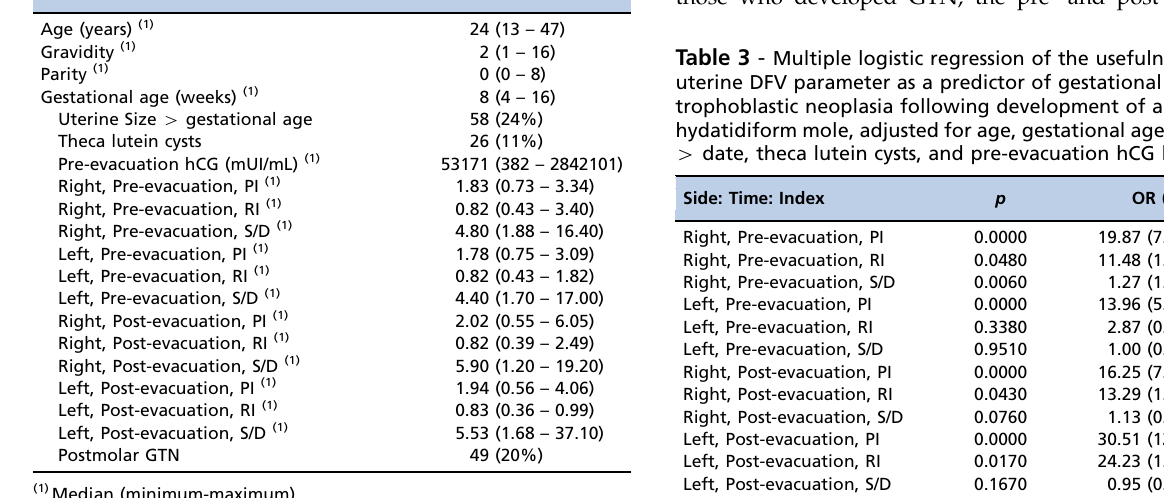
Table 1 - Patient characteristics ( n = 246) and pre- and post- evacuation uterine artery DFV measurements. Variable